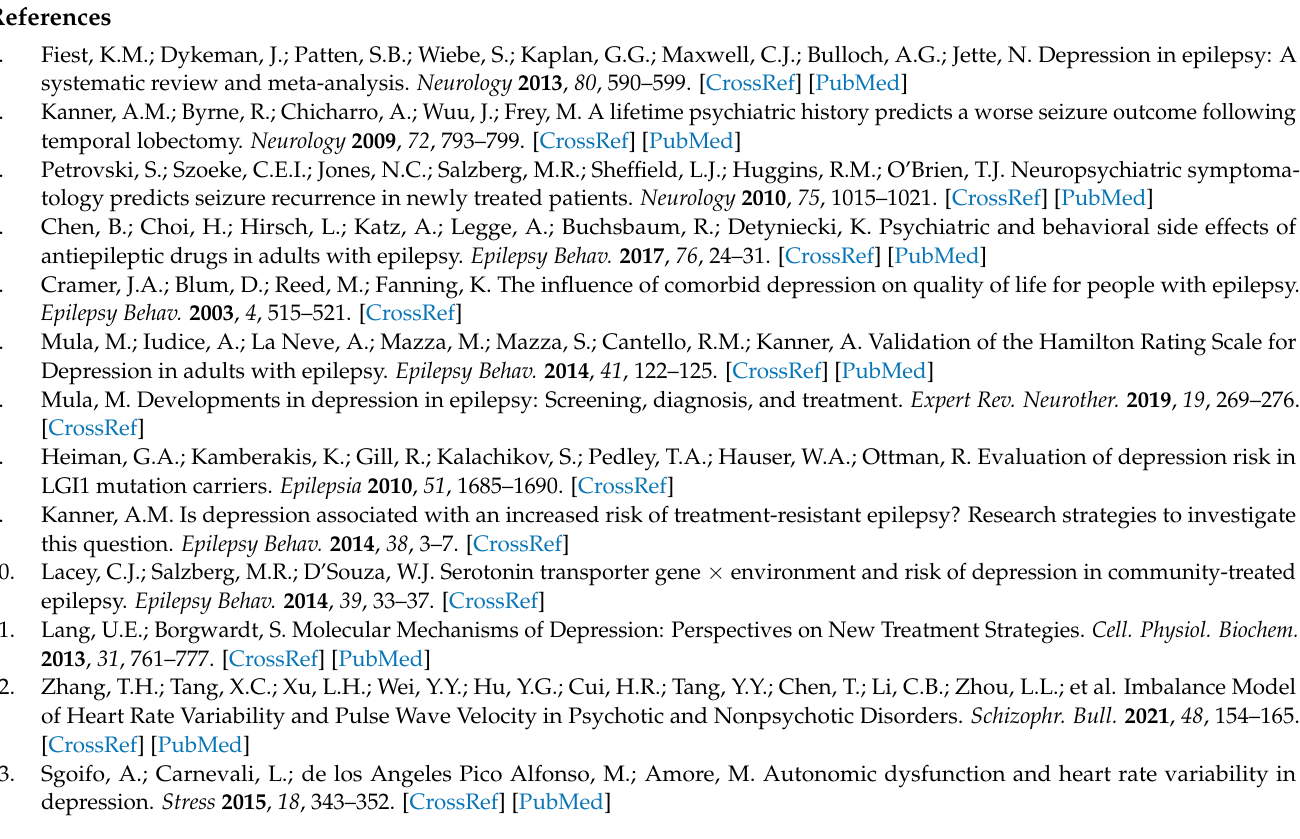
Figure A2. Power spectral density (PSD) measurements showed abnormal patterns between non- epilepsy control group and people with epilepsy (PwE). ( A ) Topographical representation of the four frequency band ( δ (0.3–3.5 Hz), θ (4–7.5 Hz), α (8–13 Hz), β (14–30 Hz)) in epilepsy and non-epilepsy controls. ( B ) PSD values showed significantly differences between epilepsy and non-epilepsy controls, especially in the channels of temporal lobe in θ -band. * p < 0.05.